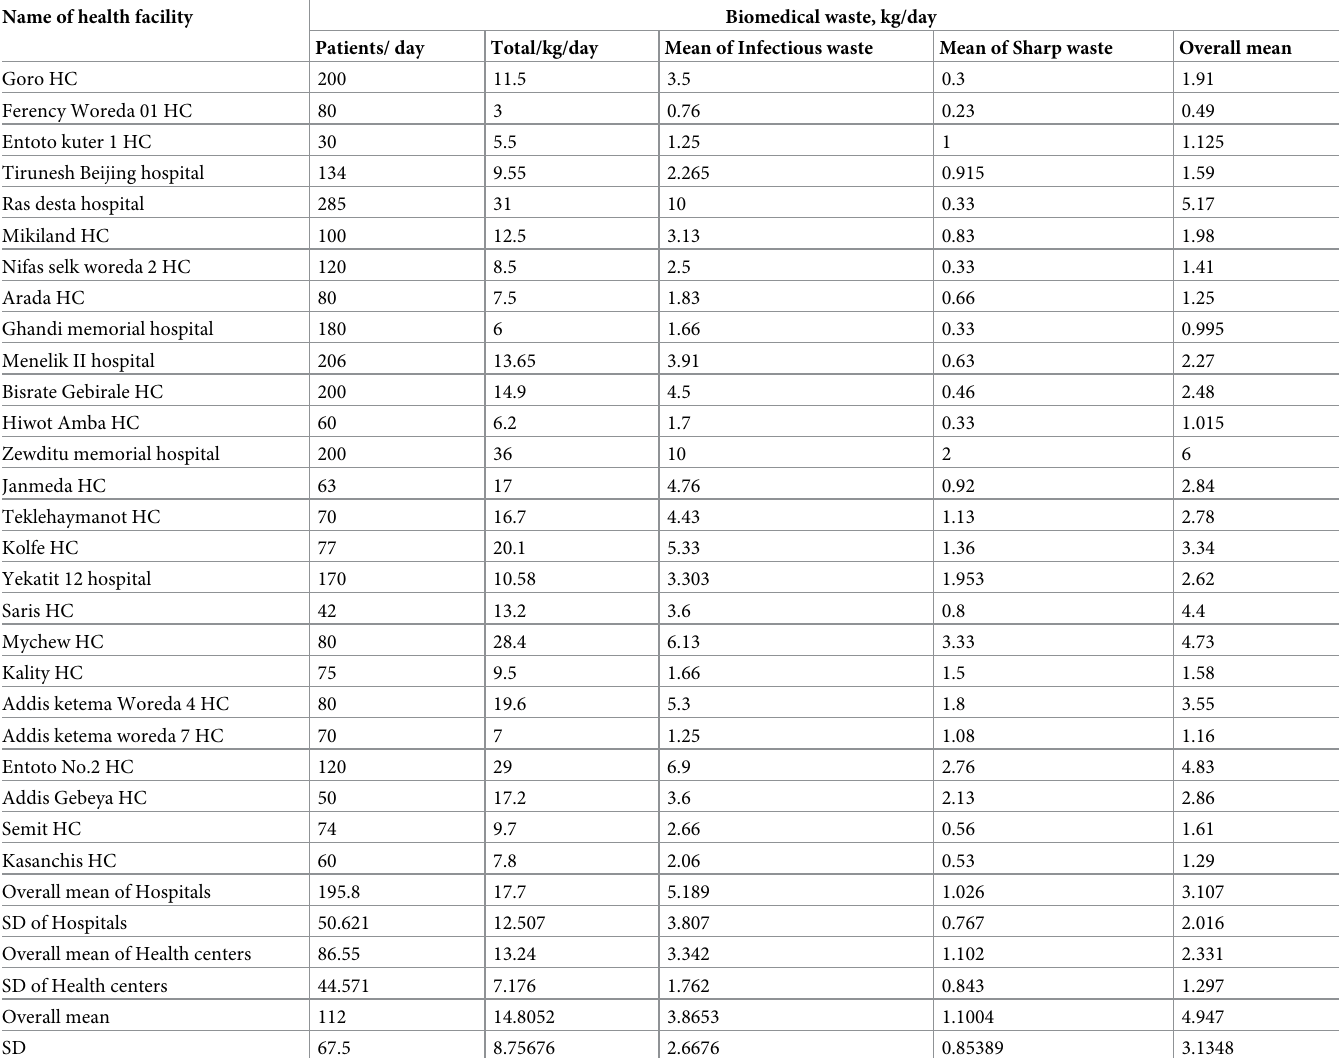
Table 3. Daily laboratory solid waste generation rate in public health care facilities in Addis Ababa, Ethiopia, 2021 (n = 26). Name of health